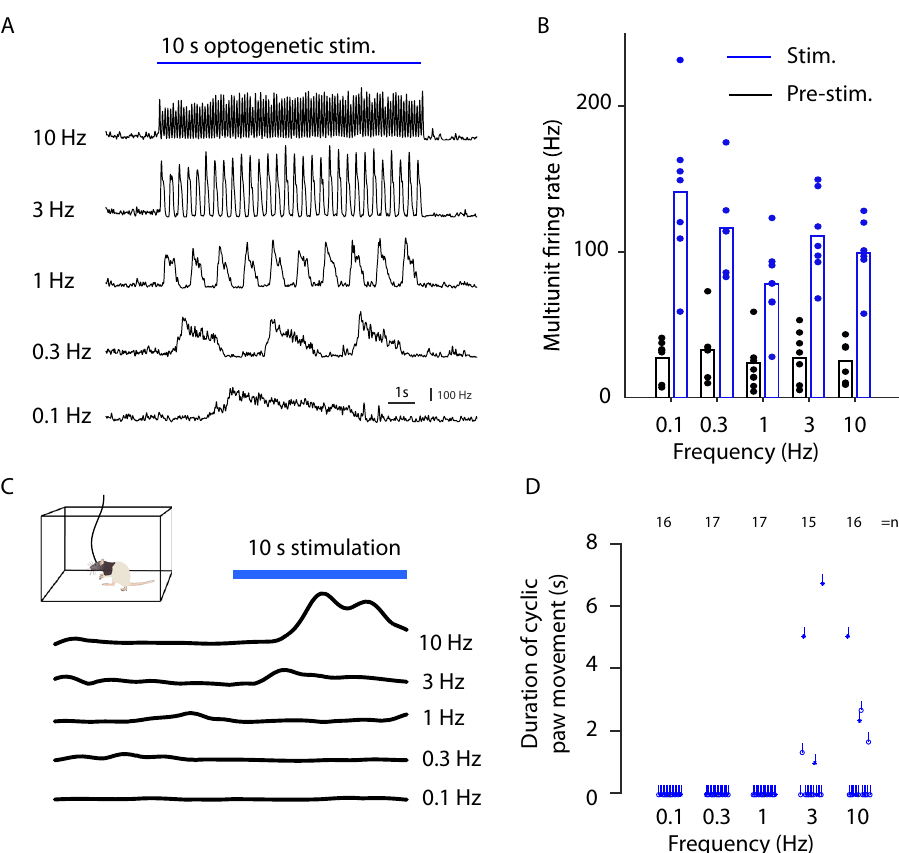
Fig. 7 Optogenetic induction of movement. A Simultaneous extracellular recordings and optogenetic stimulation at fi ve different frequencies averaged across two animals. The instantaneous fi ring rate was estimated by threshold crossings in 10-ms-bins for the stimulation period of 10 s. B Average fi ring rate before (black) and during stimulation (blue) for different trials (dots) from two animals. The bars indicate the average fi ring rate. C Optogenetic stimulation in a Plexiglas arena surrounded by seven cameras for behavioral tracking 77 . The behavior was quanti fi ed as the amplitude of the velocity for respective stimulation frequencies (black lines). Rat drawing originates from doi.org/10.5281/zenodo.3926015. D Behavioral quanti fi cation for different stimulation frequencies. Each line corresponds to the duration of repetitive up/down paw movements in a stimulation trial. Optogenetic stimulation did not evoke any cyclic movements in the trials for frequencies 0.1 (16 trials), 0.3 (17 trials), and 1 Hz (17 trials). Only optogenetic stimulation applied with ≥ 3 Hz induced overt cyclic movements. Source data are provided as a Source Data fi